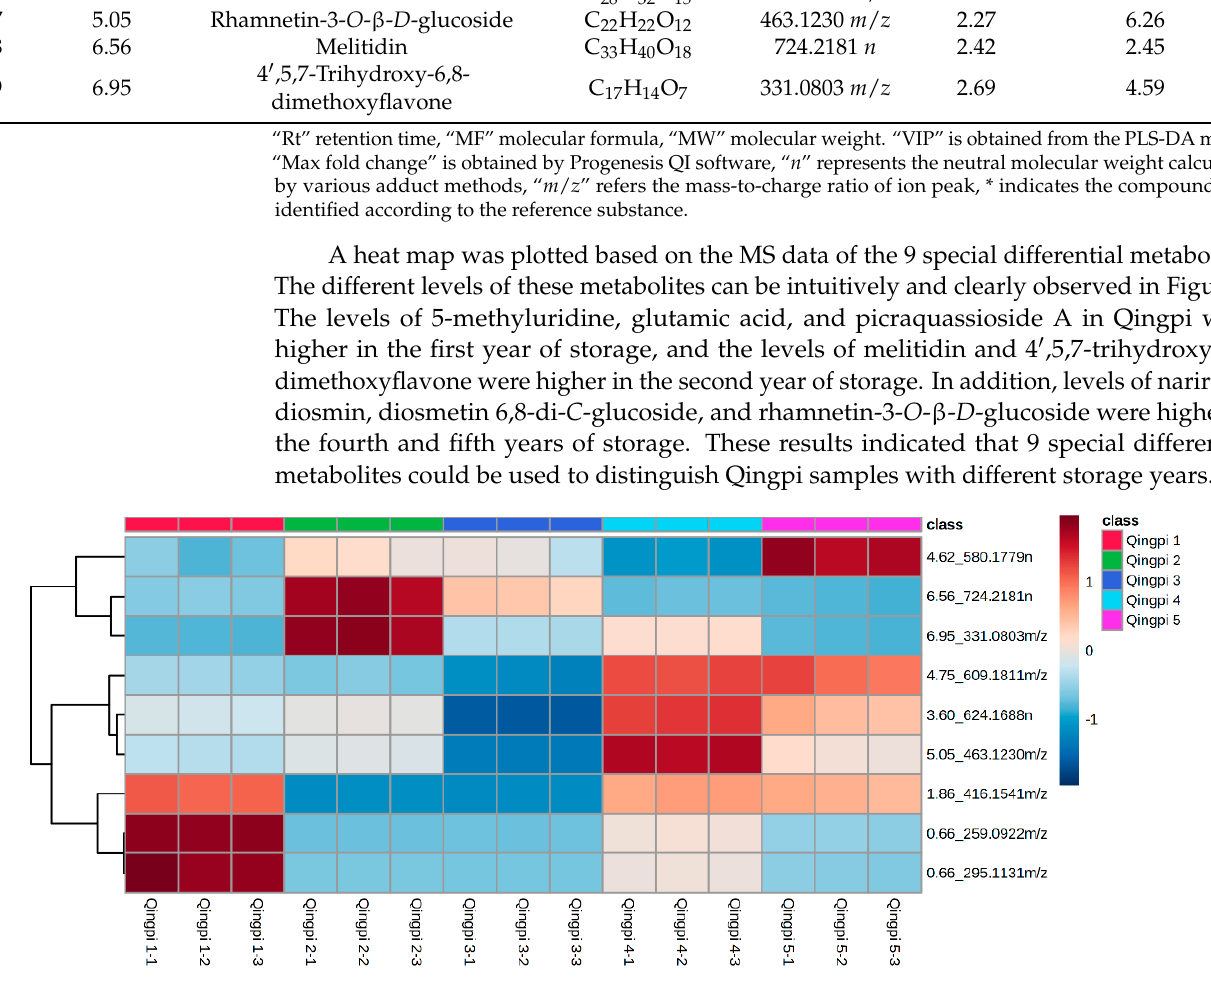
Figure 7. Heat map of 9 special differential metabolites in Qingpi 1, Qingpi 2, Qingpi 3, Qingpi 4, and Qingpi 5 samples during 1, 2, 3, 4, and 5 years of storage, respectively. Among the 9 special differential metabolites, 6 compounds were flavonoids. Interestingly, three flavonoids (hesperidin, nobiletin, and tangeretin), with their content previously determined, did not belong to the special differential metabolites. The reason may be that the screening of special differential metabolites must simultaneously meet three conditions described. Among them, narirutin is a dihydroxy flavanone glycoside with some anti-cancer, neuroprotective, stress-relieving, liver-protecting, anti-allergic, anti-diabetic, anti-obesity, antioxidant, anti-inflammatory, and immunomodulatory effects [55]. Diosmetin 6,8-di- C -glucoside is a flavonoid glycoside with some anti-oxidation, anti-aging [56], and anti-edema effects [49]. Diosmin is a flavanone glycoside with chondro- protective effects for human articular chondrocytes under oxidative stress [57], potential protective effects against streptozotocin-induced diabetic cardiomyopathy in rats [58],